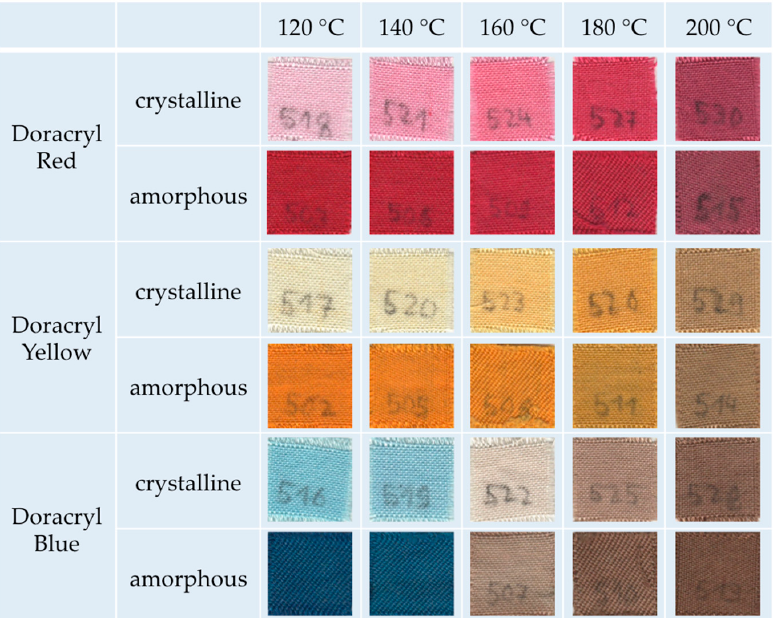
Figure 3. Temperature-dependent dyeing of amorphous and crystalline m-aramid fabrics with various cationic dyes in EMIM-EtSO 4 .